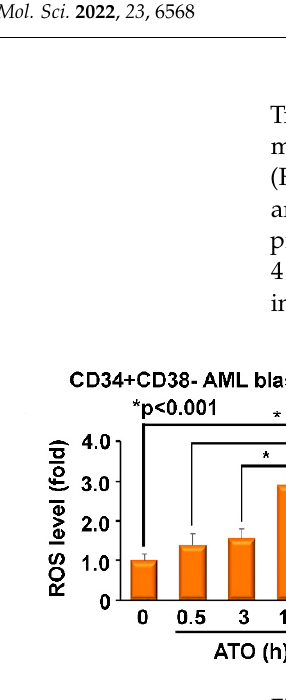
Figure 1. ATO induces ROS and p-AKT in LSC-enriched AML progenitor cells. ( A – C ) Effects of ATO on levels of Akt phosphorylation and mitochondrial ROS in LSC-enriched progenitor cells. LSC-enriched progenitor cells (CD34+CD38- enriched blast cell population, n = 5, pooled samples) were treated with 500 nM ATO for up to 12 h, as indicated. ( A ) ROS levels were measured by flow cytometry using mitoSox staining. ( B ) Cell lysate was immunoblotted with indicated antibodies. ( C ) Left, LSC-enriched progenitor cells were treated with for 3 and 12 h. the indicated times. Right, LSC-enriched progenitor cells were co-treated with 500 nM ATO and DMSO or 10 µM LY294002 for 3 h. Cell lysate was immunoblotted with indicated antibodies.